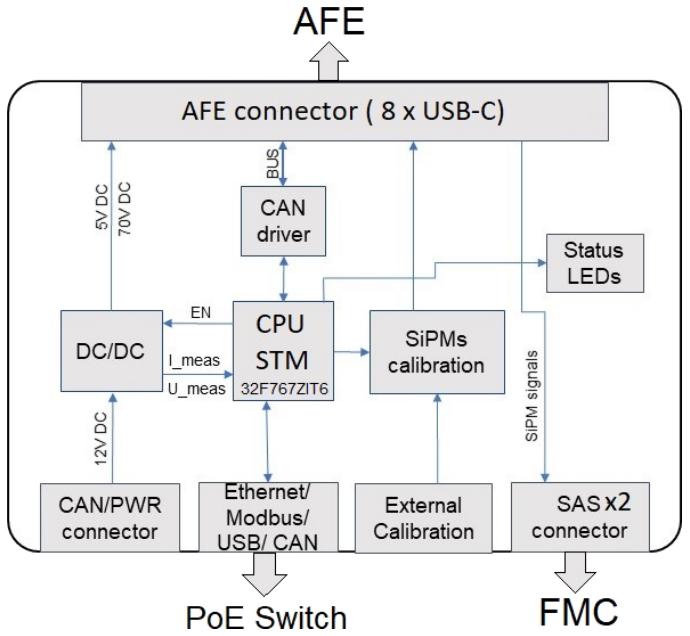
Figure 8. MCORD HUB idea